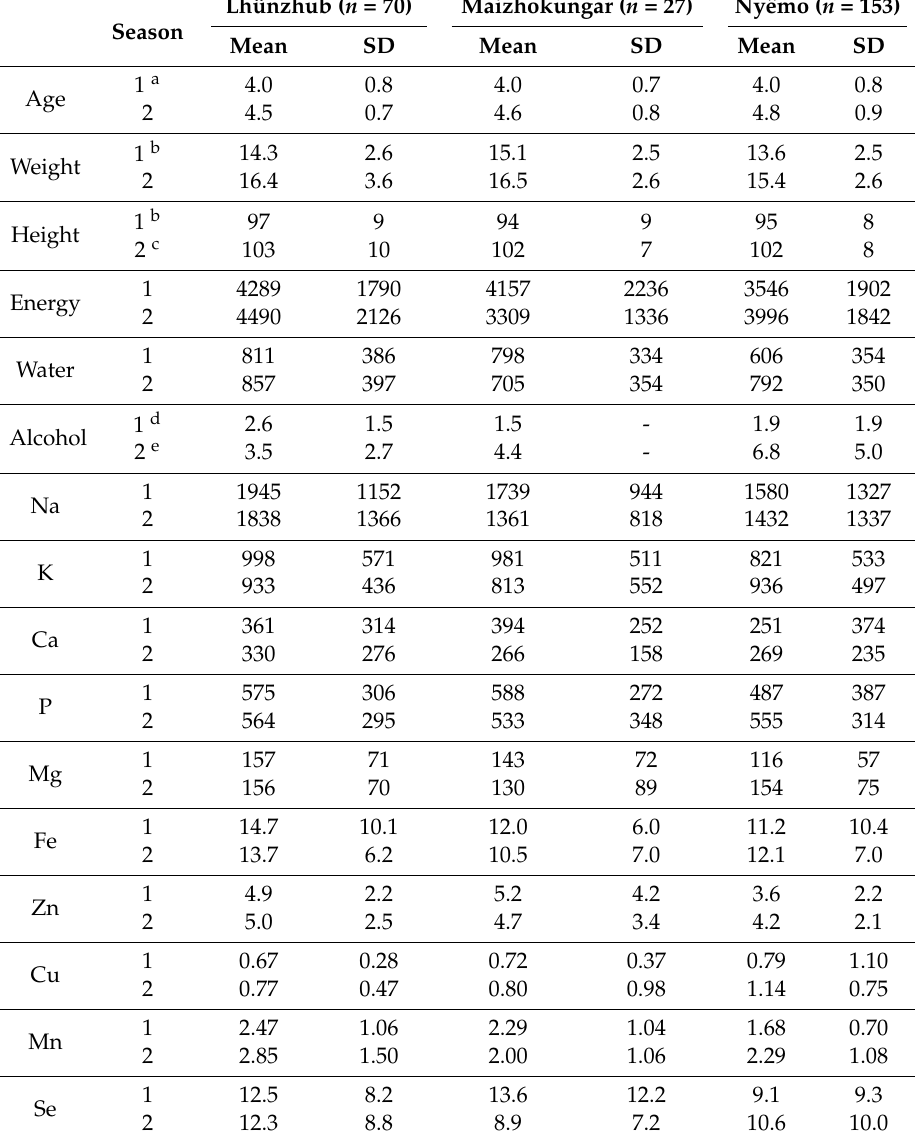
Table 2. Demographic factors and dietary intakes by county and by season. Lhünzhub ( n =